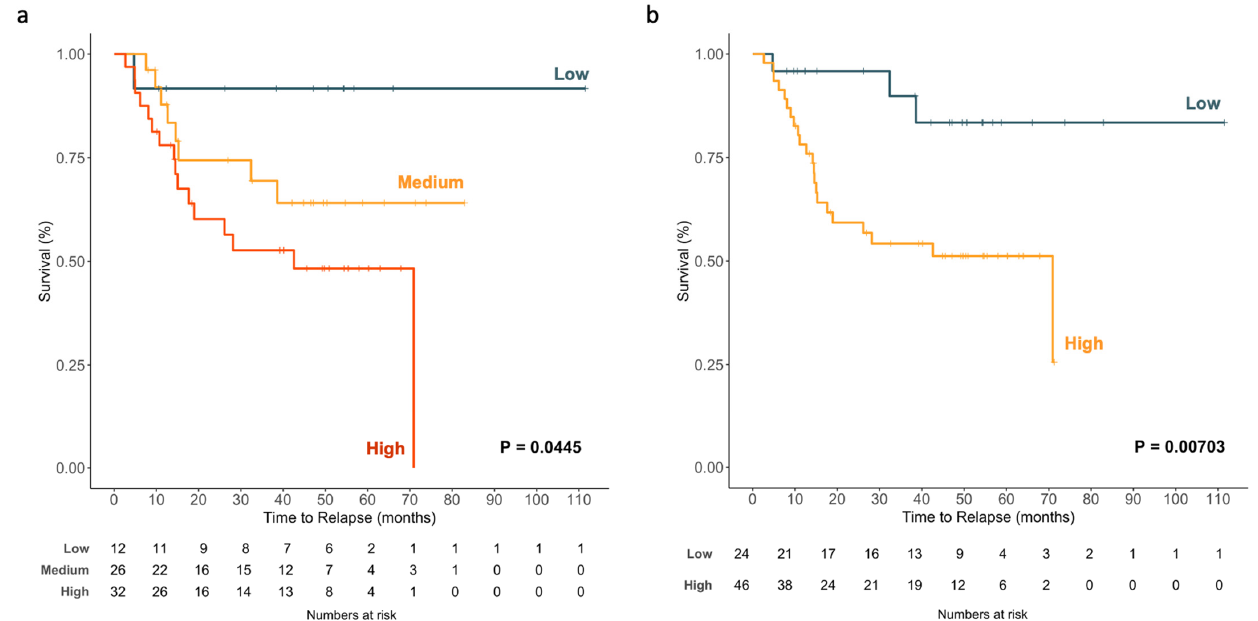
Figure 8. Kaplan–Meier survival analysis of TDV EV-miR-203a-3p and TTR among patients with NSCLC: ( a ) Patients were classified according to TDV EV-miR-203a-3p levels as low, medium or high. ( b ) Patients were classified as low or high according to the cutoff identified in the ROC curve analysis.